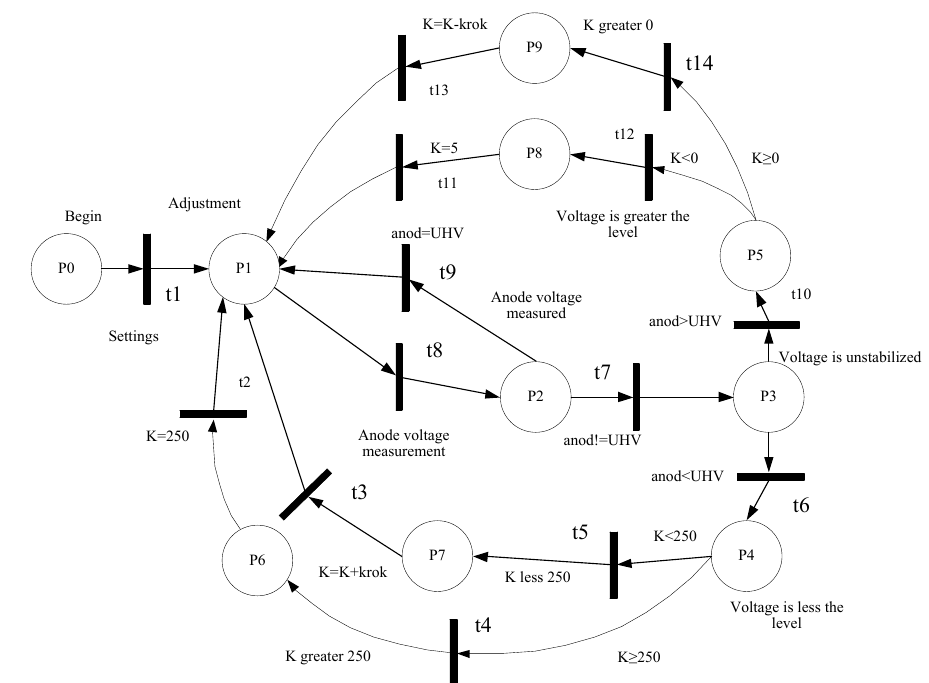
Figure 4. Schematic view of the model based on Petri nets for researching the process dynamics of the anode voltage adjustment for the Geiger–Mueller counter.